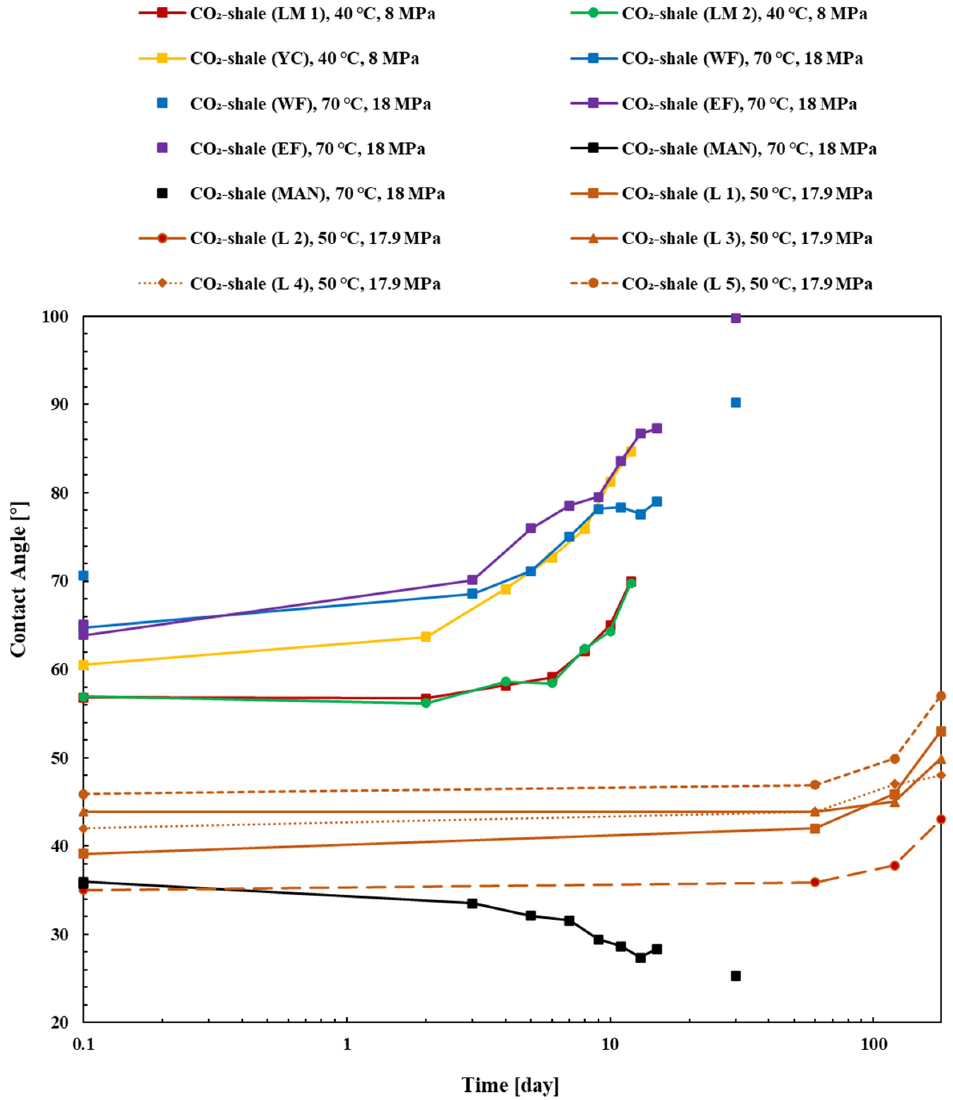
Figure 6. Water contact angle as a function of reaction duration in the H 2 O-rock systems after reaction with CO 2 [13,28,29,54,55]. The contact angle for conditions of 50 °C and 17.9 MPa are advancing; as is the contact angle measured at 50 °C and 15 MPa [28]. To facilitate data analysis, the starting point 0 was approximated to 0.1.